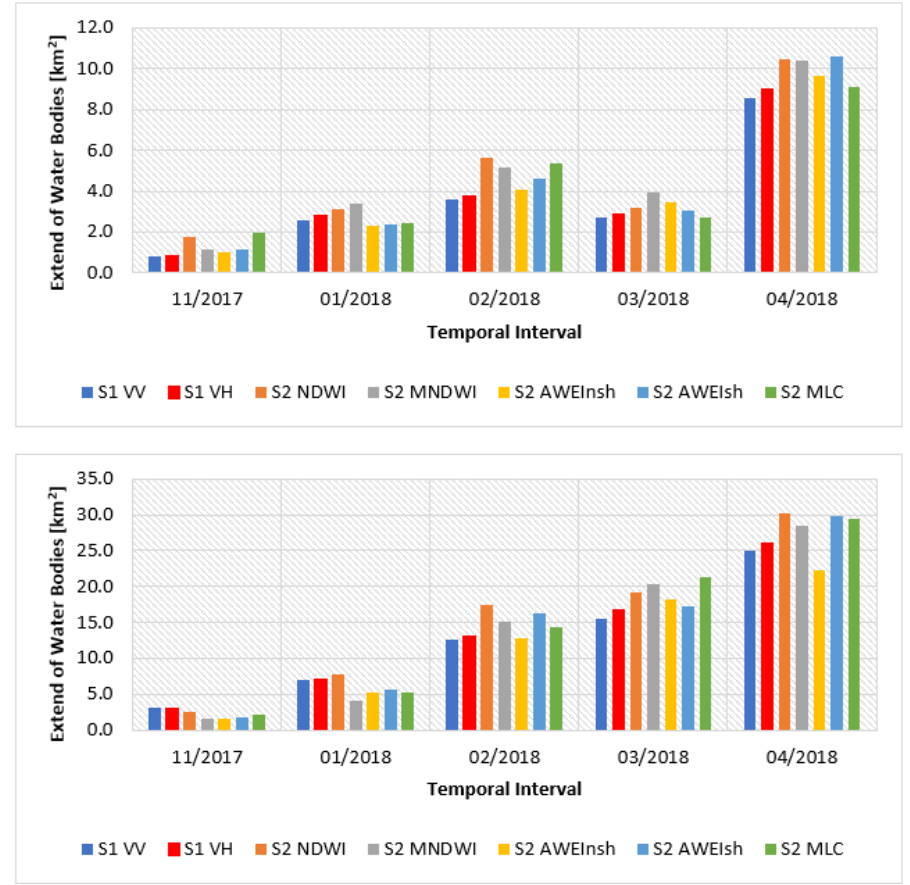
Figure 14. The resulting temporal numerical evaluation of changes in the extent of water areas in localities 2 and 3 with a comparison of extraction methods.